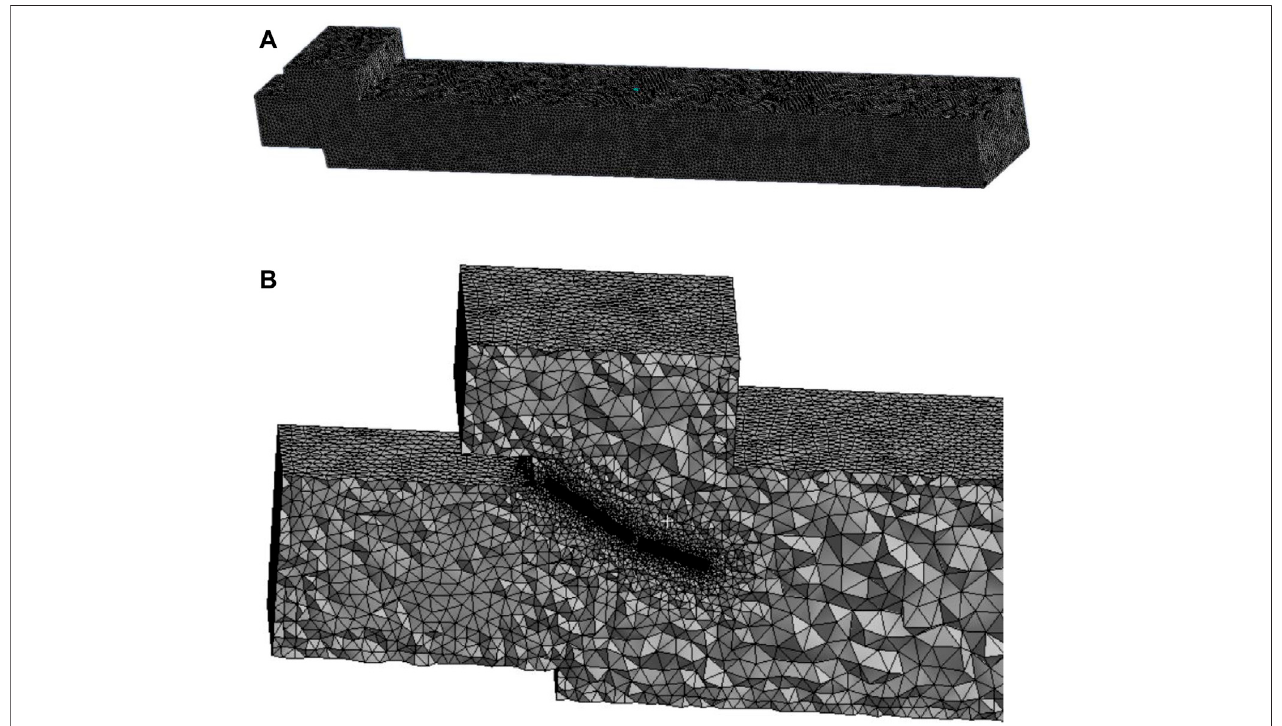
FIGURE 9 | Diagram of the grid division: (A) overall grid diagram and (B) local grid diagram.